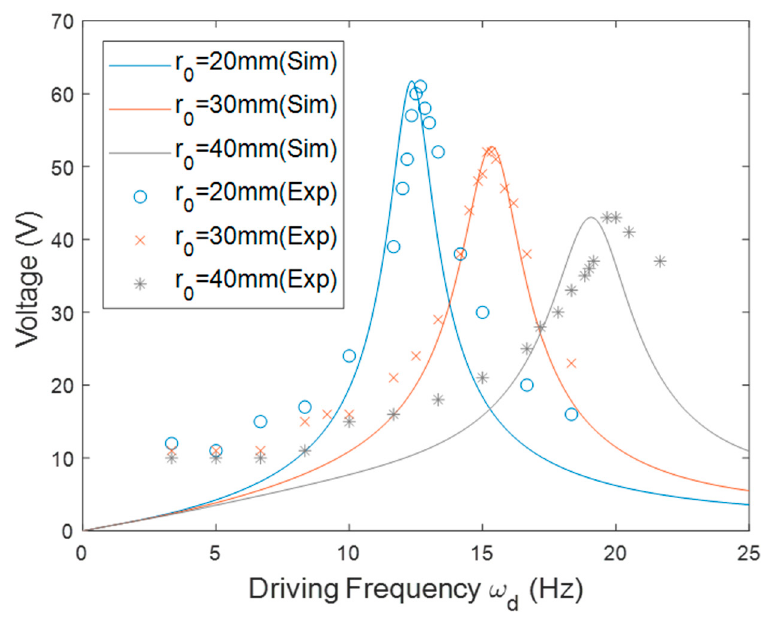
Figure 6. The simulation and experimental voltage responses of the PEH in the outward orientation with different r 0 .